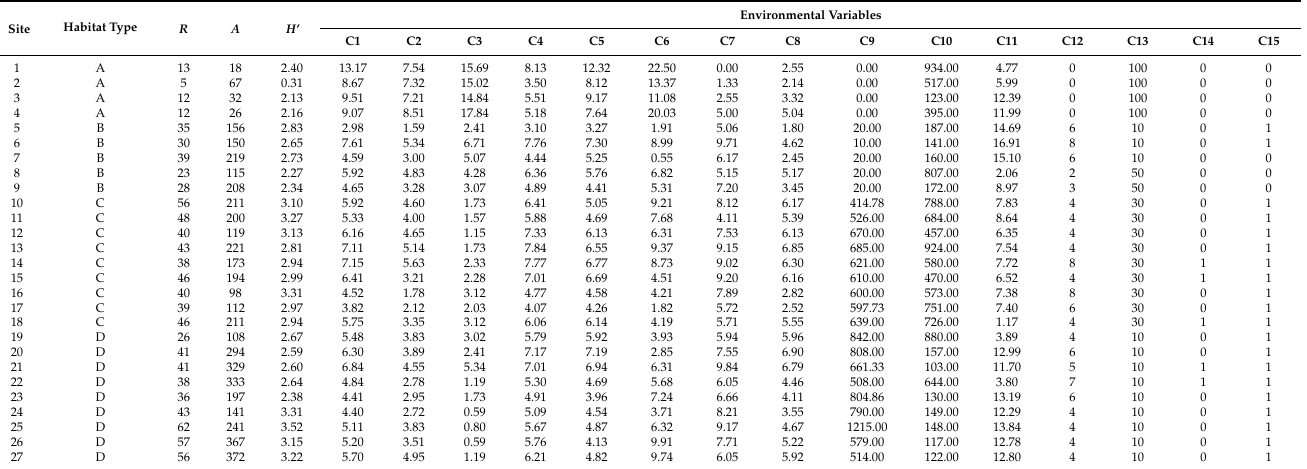
Table 1. Characteristics of bee communities ( R = species richness, A = abundance, H ’ = Shannon diversity index) and vegetation structure at the study sites (habitat types: A = forests; B = clearings; C = infiltration ditches; D = infiltration